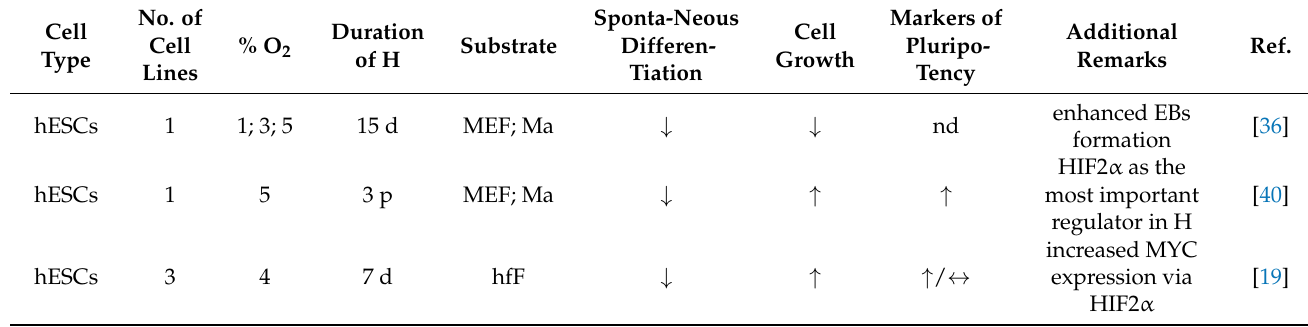
Table 1. The impact of hypoxia on pluripotent stem cells. The table describes changes observed under hypoxia compared to normoxia conditions. Abbreviations: ↑ —upregulated; ↓ —downregulated; ↔ —unchanged; d—days; H—hypoxia; hESCs—human embryonic stem cells; hfF—human foreskin fibroblasts; hiPSCs—human induced pluripotent stem